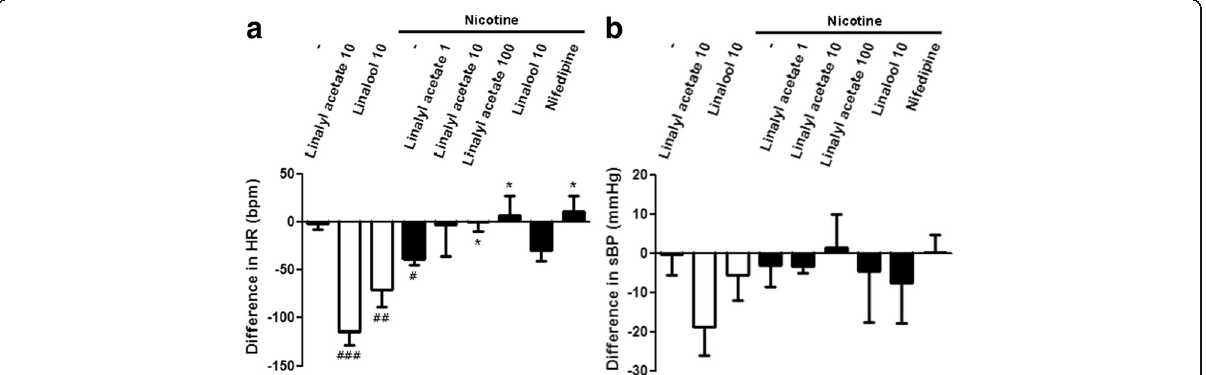
Fig. 1 Linalyl acetate- and linalool-induced cardiovascular effects in nicotine-untreated and treated rats. a HR and b sBP are expressed as the difference between pre-test and post-test. Data represent mean values ± S.E.M. ( n = 5 – 13 per group). ### p < 0.001, ## p < 0.01, # p < 0.05 compared with the control group; * p < 0.05 compared with nicotine group. HR: heart rate; sBP: systolic blood